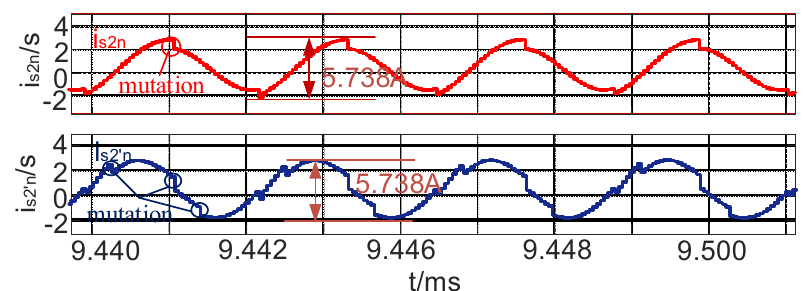
Figure 16. Traditional topological static 180° phase-shifting input current waveform .